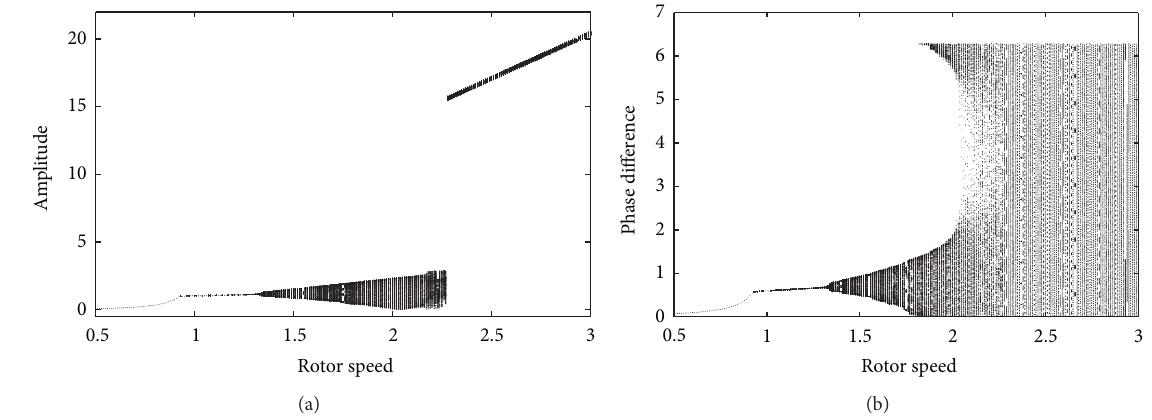
Figure 3: Bifurcation diagrams of (a) radial displacement amplitude and (b) phase difference.